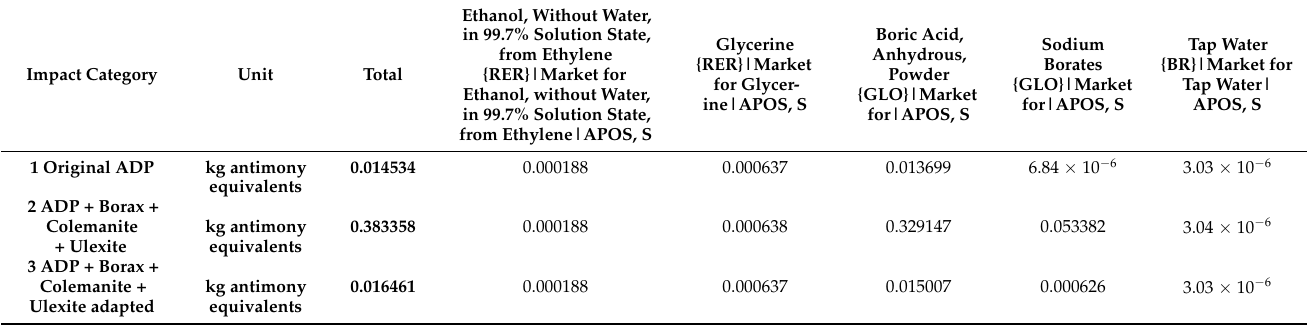
Table 10. Characterized value of the detergent expressed in kg antimony equivalents.